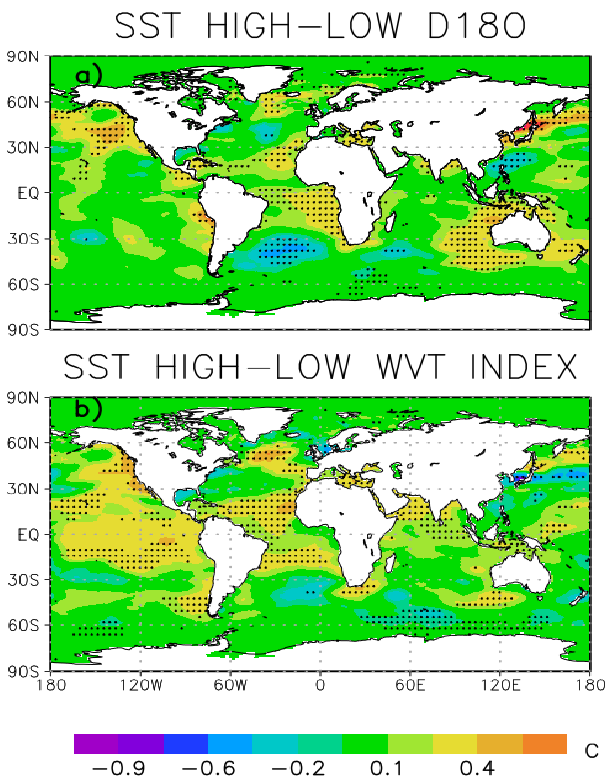
Figure 7. ( a ) The difference between composite maps of SST associated with high and, respectively, low ice core δ 18 O winters ( b ) as in ( a ) but for the extreme WVT index (see text for definition). Regions where the differences are significant at the 90% level are dotted. Units: °C.